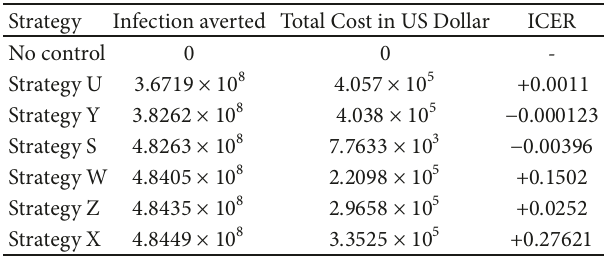
Table 4: The cost and infection averted for controls S, W, Z, and